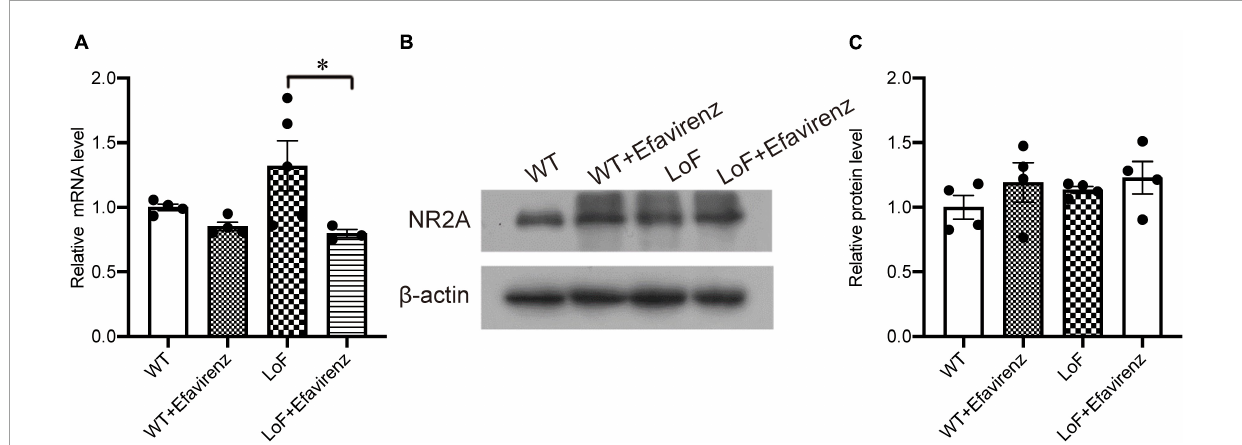
FIGURE1 mRNA and protein expressions of NR2A in the hippocampi of GRIN2A-V685G mutant mice. GRIN2A-V685G mutant mice were established on C57BL/6N background. The mRNA and protein levels of NR2A were assessed at the age of 8 weeks. (A) mRNA level, (B) protein level, (C) relative protein level. ∗ P < 0.05.